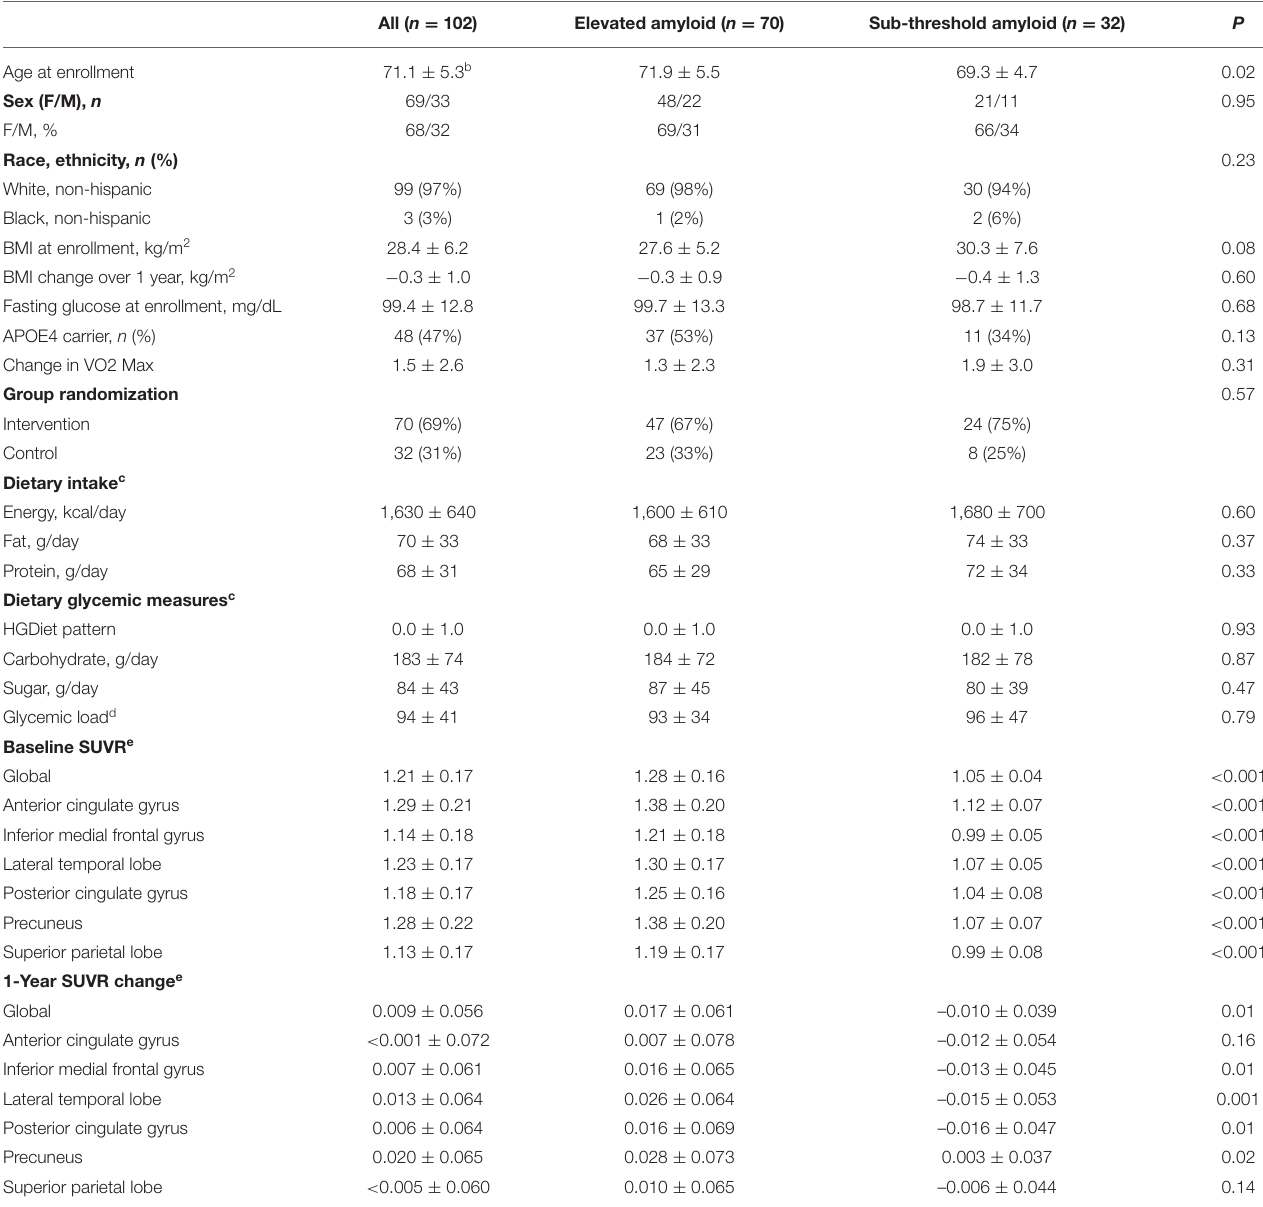
TABLE 1 | Participant Characteristics a .